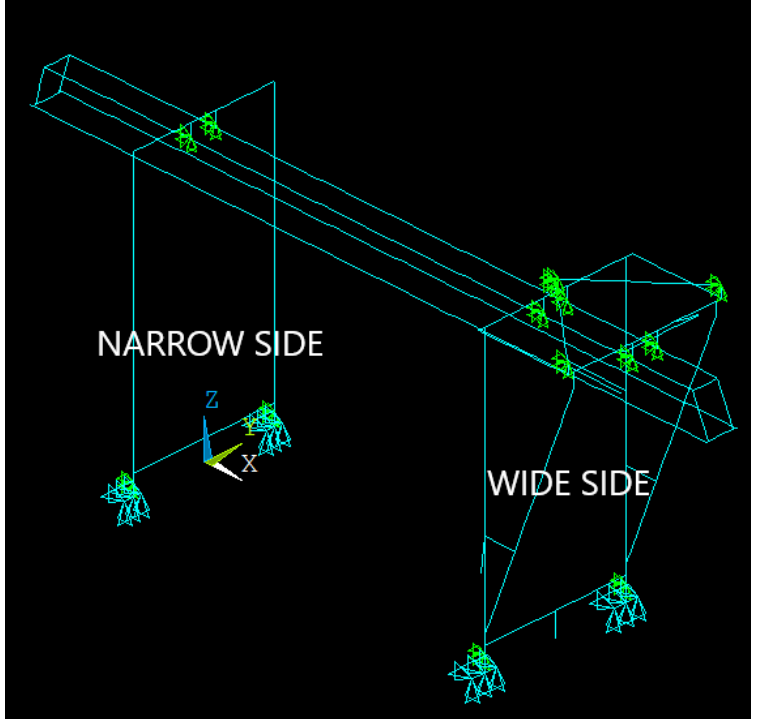
Figure 1. Line Diagram with Boundary Conditions and Couplings for the